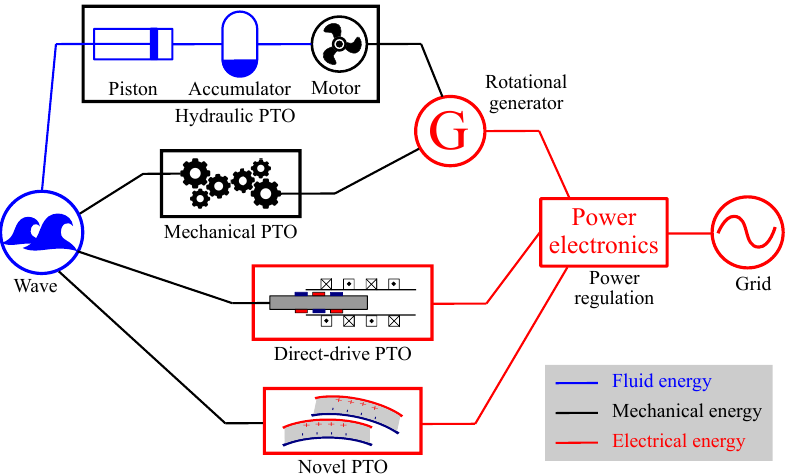
Figure 12. Four types of power take-off mechanisms used for point absorber wave energy converters.